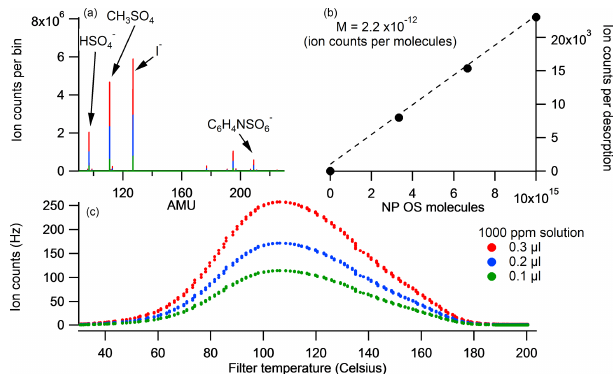
Figure 2. The desorption profile of NP OS 3-step calibrations for 0.1, 0.2 and 0.3µL 1000ppm solution is displayed in panel (c) . Its corresponding average stick spectra are shown in (a) and the sum of counts per molecule loading for each calibration is shown in (b)